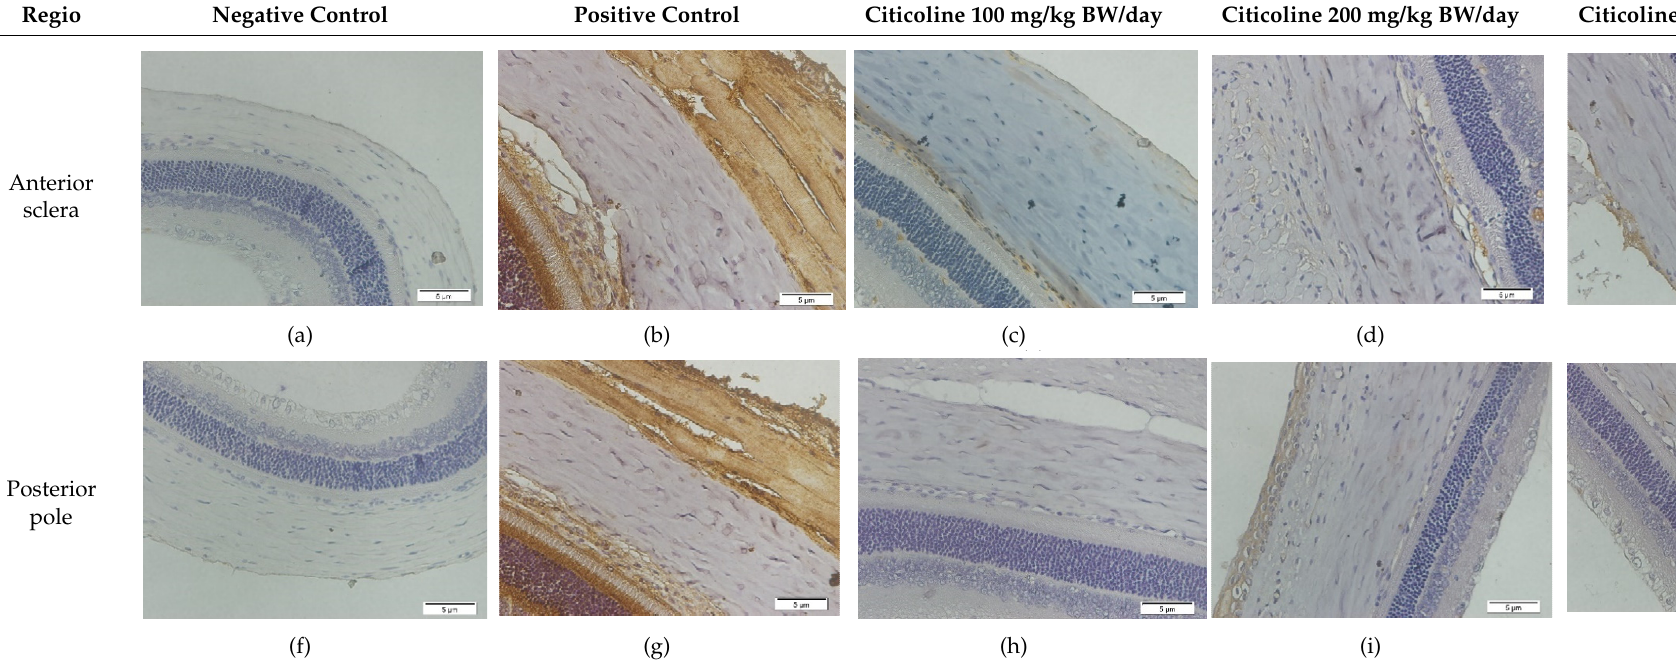
Table 2. Measurements of fibroblast proliferation using Ki-67.